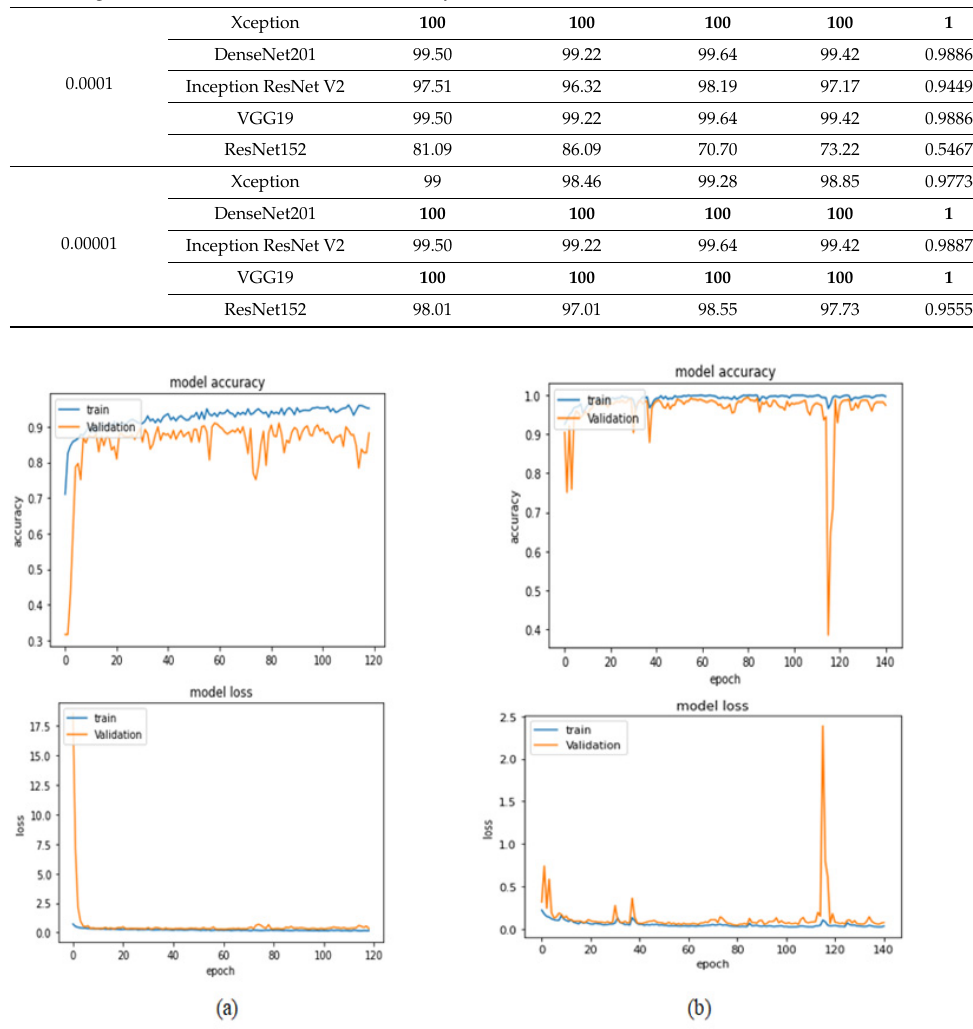
Figure 13. Learning curves for VGG19 at 0.00001 learning rate in 40 × magnification dependent binary classification. ( a ) Accuracy and loss curves of Phase 1 of training. ( b ) Accuracy and loss curves of Phase 2 of training.